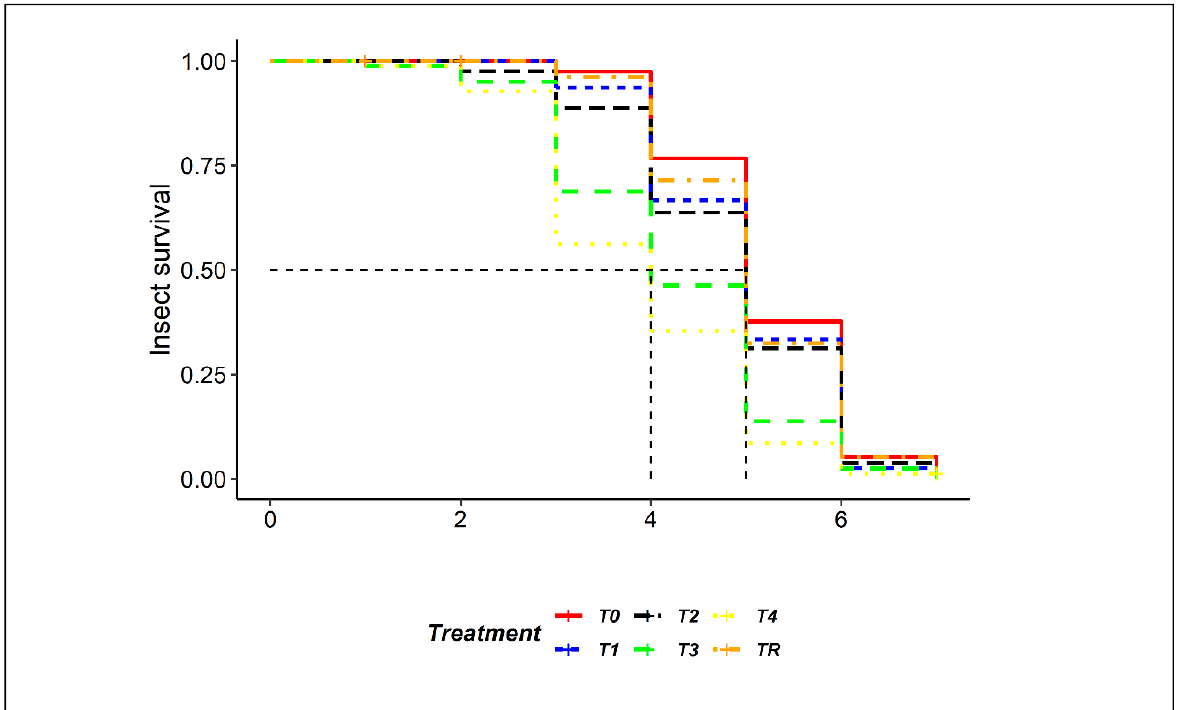
Figure 2 : Survival curves of insects according to different treatments with ethanolic extract of C.